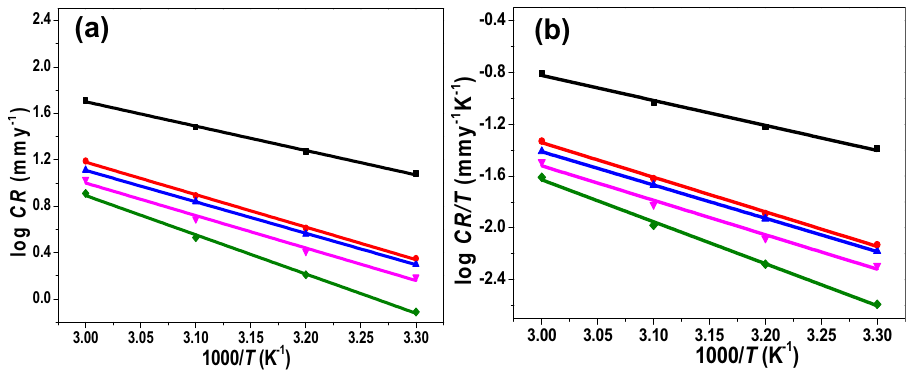
Fig. 8 a Arrhenius plot and b Transition state plot for the corrosion of steel in 1 M HCl without and with Et-ACPE and Et-AgNPs. Key: Black = 1 M HCl; red = 500 mg/L Et-ACPE; blue = 100 mg/L Et-AgNPs; purple = 200 mg/L Et-AgNPs; green = 500 mg/L Et-AgNPs)